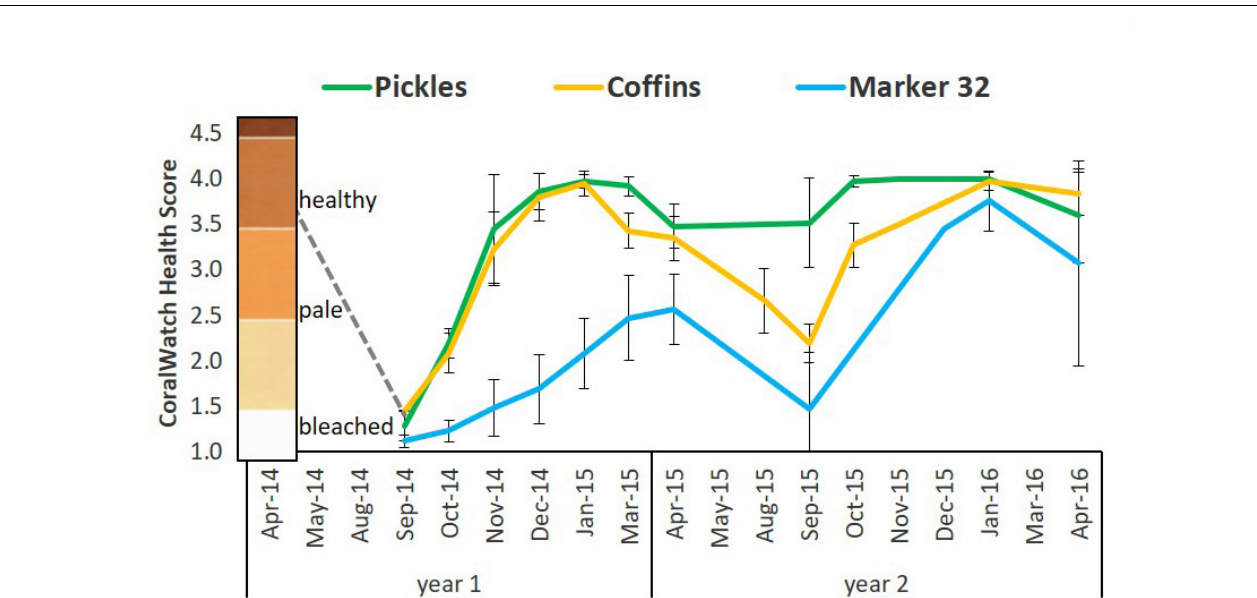
FIGURE 5 | Mean bleaching index based on coloration scores of D. cylindrus colonies at three sites on the FRT between 2014 and 2016. The coloration scores were determined using the CoralWatch Coral Health Chart for colorimetric reference (version: Project Aware https://coralwatch.org; Siebeck et al., 2006). Coloration ranges for D. cylindrus based on triannual assessments of 168 colonies: healthy 3.5–4.0; pale: 2.0–3.0; bleached: 1.0–1.5. Dashed gray line represents trajectory of estimated colony scores from April 2014. Pickles ( n = 12) Upper Keys; Coffins ( n = 12) Middle Keys; Marker 32 ( n = 11) Lower Keys. Error bars ± 1 standard